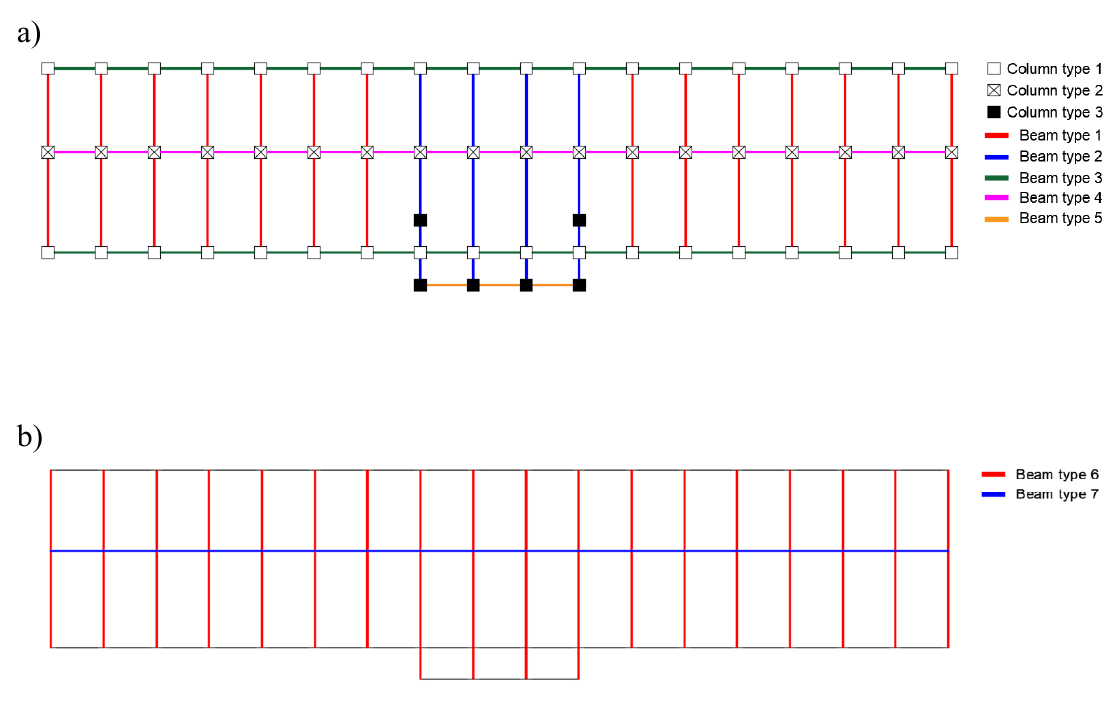
Figure 4. Identification and location of the different beams and columns typologies according to Table 1. ( a ) Stories 1 ‐ 4. ( b ) Story 5 (Roof).